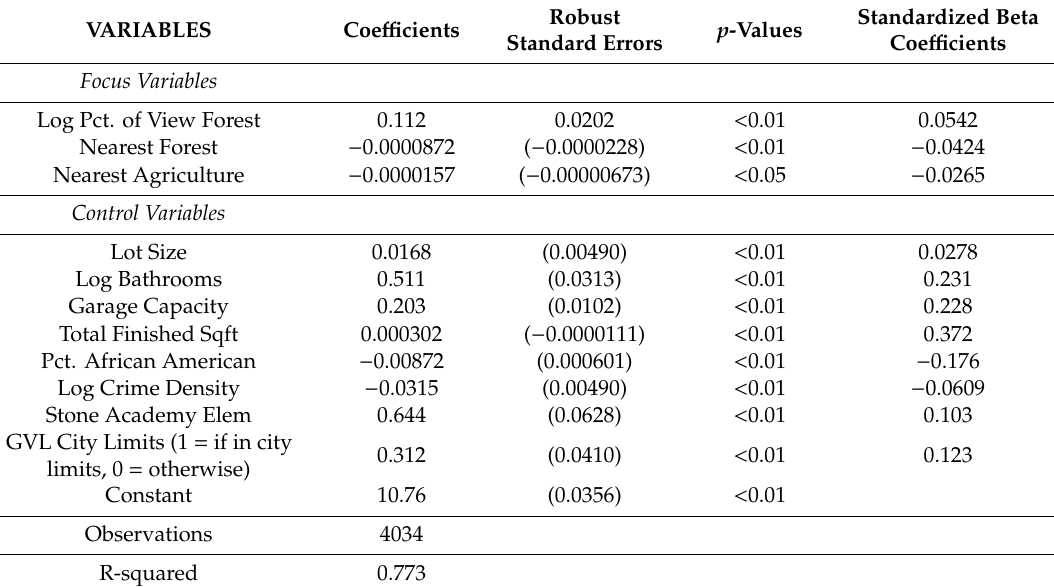
Table 2. Global OLS hedonic model results. All coe ffi cient values are significant at the 5% significance level. Only the most significant school is shown in the table, but all positively valued schools were controlled for in the